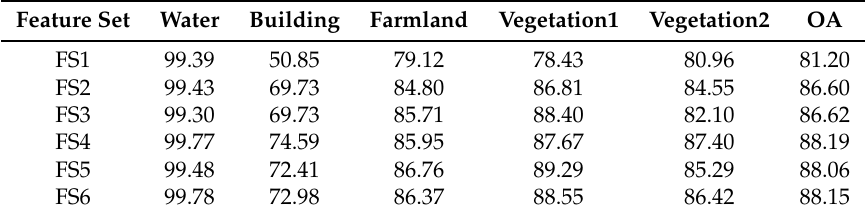
Table 8. Accuracies by classes and OAs with different feature sets on data set B (%).